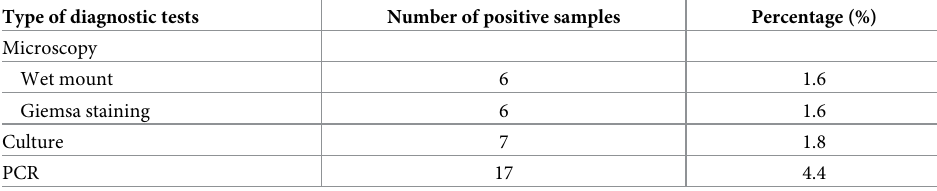
Table 2. Prevalence of T . vaginalis infection by microscopy, culture, and